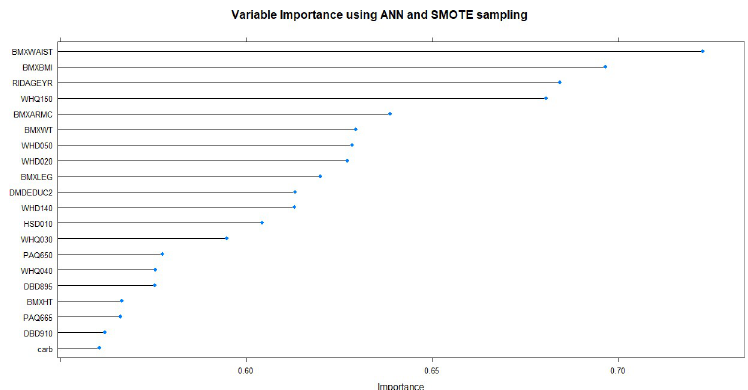
Fig 10. Variable importance plot of the best-performing artificial neural network models produced by SMOTE resampling. BMXWAIST = waist circumference; BMXBMI = body mass index; RIDAGEYR = age; WHQ150 = age when heaviest weight; BMXARMC = arm circumference; BMXWT = weight; WHD050 = self-reported weight– 1 year ago; WHD020 = current self-reported weight; BMXLEG = upper leg length; DMDEDUC2 = education level; WHD140 = self-reported greatest weight; HSD010 = self-rated general health; WHQ030 = How do you consider your weight?; PAQ650 = vigorous recreational activities; WHQ040 = Like to weigh more, less, or same?; DBD895 = number of meals not home prepared; BMXHT = standing height; PAQ665 = moderate recreational activities; DBD910 = number of frozen meals/pizzas in past 30 days; carb = carbohydrate.